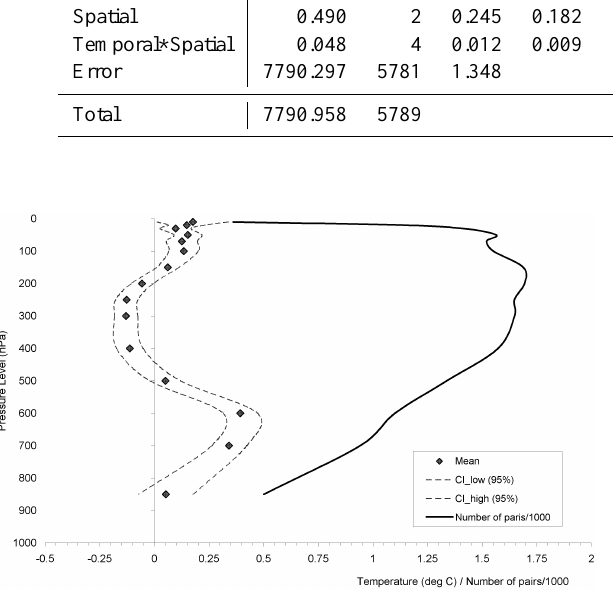
Fig. 3. FORMOSAT-3/COSMIC temperature profile comparison results (means, 95% confident levels and numbers of comparison pairs) at 16 different pressure